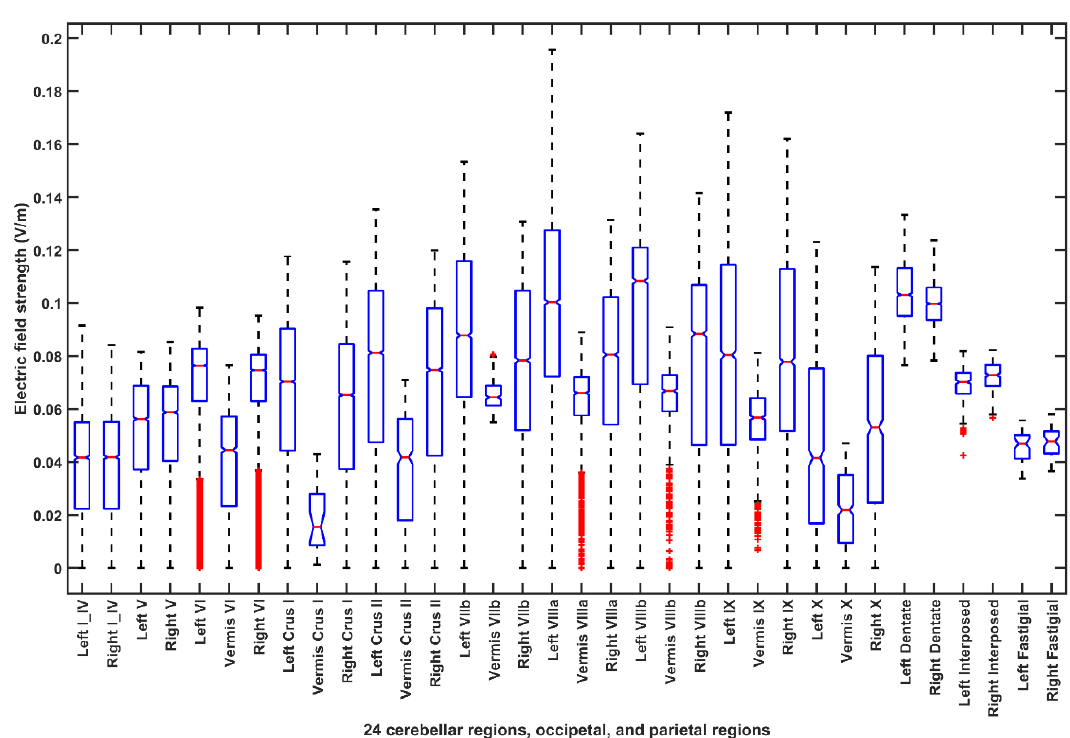
Figure 6. Boxplot of the lobular electric field distribution for the 10 post-stroke patients for the Exx7–Exx8 montage for case 2 (optimization for bilateral lobules VII–IX).